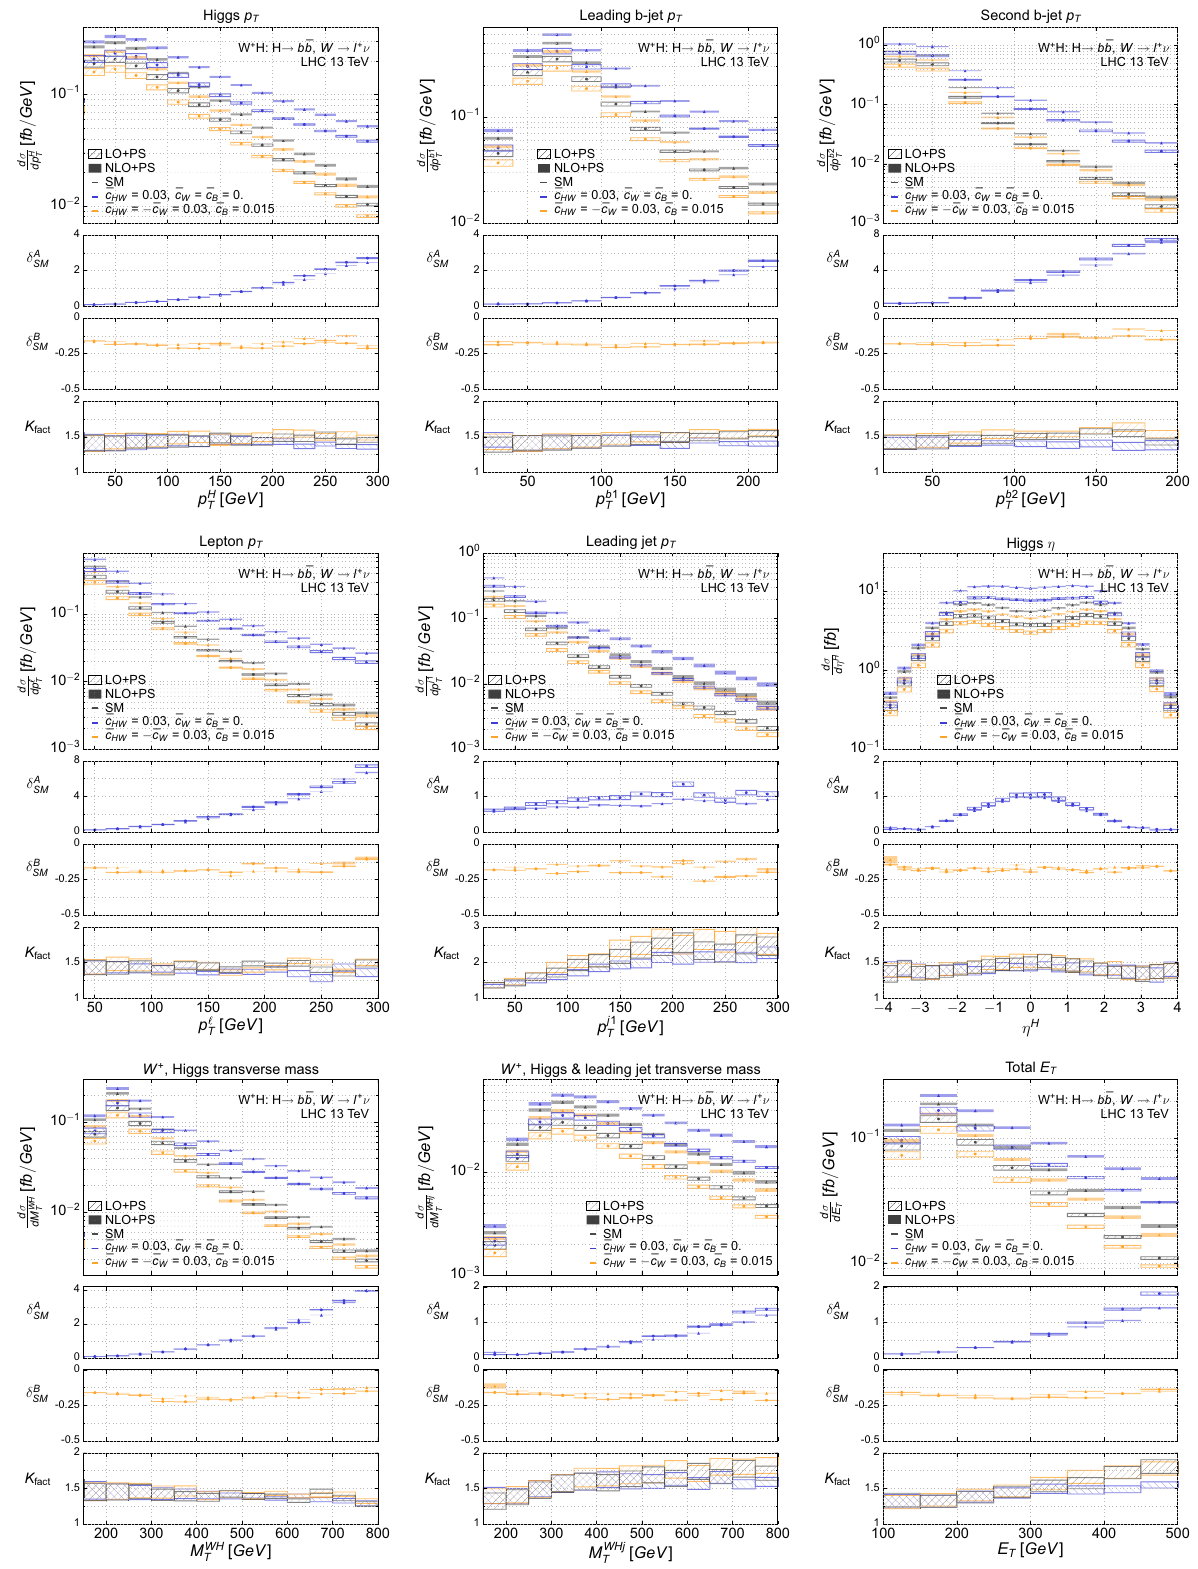
Fig. 1 Selection of W H differential distributions at the (N)LO+PS accuracy in which the SM predictions are compared with results obtained for the two benchmark scenarios discussed in Sect. 2.3. Our predictions include the theoretical uncertainties stemming from scale